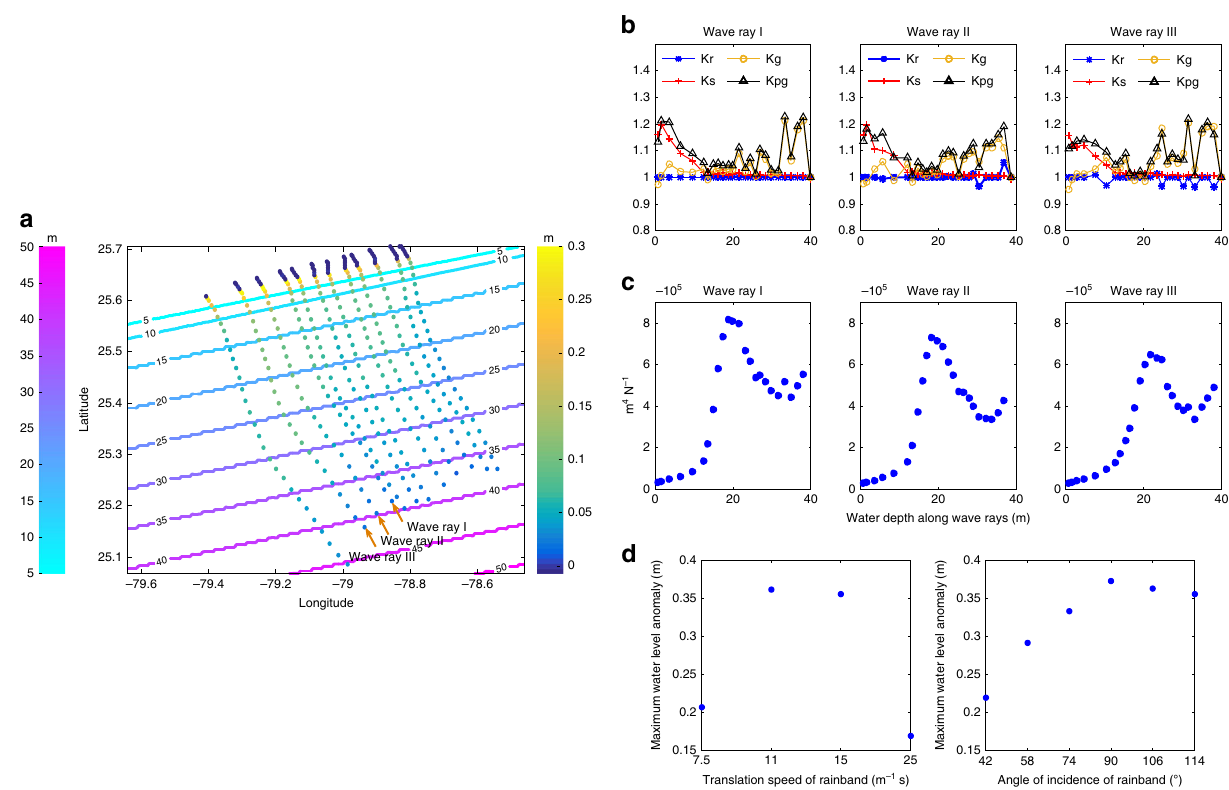
Fig. 7 Meteotsunami generation and propagation in the idealized tropical cyclone. a Considered wave rays. The idealized bathymetry is represented with the colored lines (color map on the left), modeled water level anomalies along the wave ways are depicted with colored dots (color map on the right); b Generation, evolution, and propagation (shoaling and refraction) coef fi cients along the selected wave rays; the y -axis represents the dimensionless evolution, propagation, refraction, and shoaling coef fi cients; c Ratio between the generation coef fi cient and wind divergence divided by the mean water depth ( Γ , m 4 N − 1 ) along selected wave rays; d Effects of the translation speed and angle of incidence of the rainband on the maximum water level